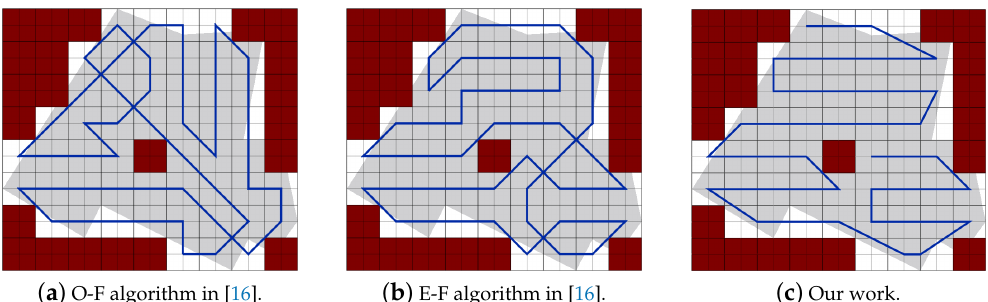
Figure 33. Paths generated by the two algorithms in [16] and by our algorithm.